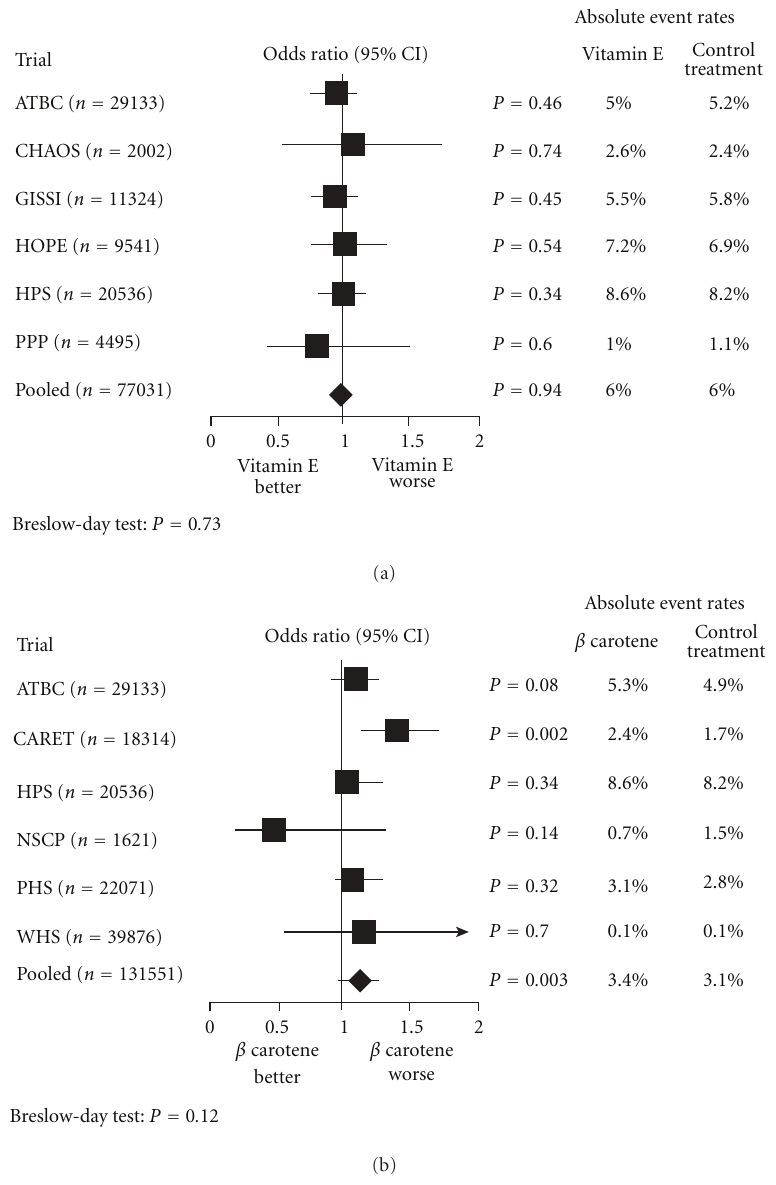
Figure 1: (a) Meta-analysis of large randomized trials of vit E versus placebo . Meta-analysis of 7 randomized trials involving 77,031 patients comparing the risk of cardiovascular death among those randomized to placebo or vitamin E (Breslow-Day test, P = 0 . 73). ATBC: α - Tocopherol, β -Carotene Cancer Prevention trial; CHAOS: Cambridge Heart Antioxidant Study; CI: Confidence Interval; GISSI – Gruppo Italiano per lo Studio della Sopravivenza nell’Infarto; HOPE: Heart Ourcomes Prevention Evaluation; HPS: Heart Protection Study; PPP: Primary Prevention Project, modified from [40]. (b) Meta-analysis of Randomized Trials of β -carotene versus Placebo. Meta-analysis of 6 randomized trials involving 131,551 patients comparing the risk of cardiovascular death among those randomized to placebo or β -carotene (Breslow-Day test, P = 0 . 12). ATBC: α -Tocopherol, β -Carotene Cancer Prevention trial; CARET: β -Carotene and Retinol E ffi cacy Trial; HPS: Heart Protection Study; NSCP: Nambour Skin Cancer Prevention; PHS: Physicians’ Health Study; WHS: Women’s Health Study, modified from